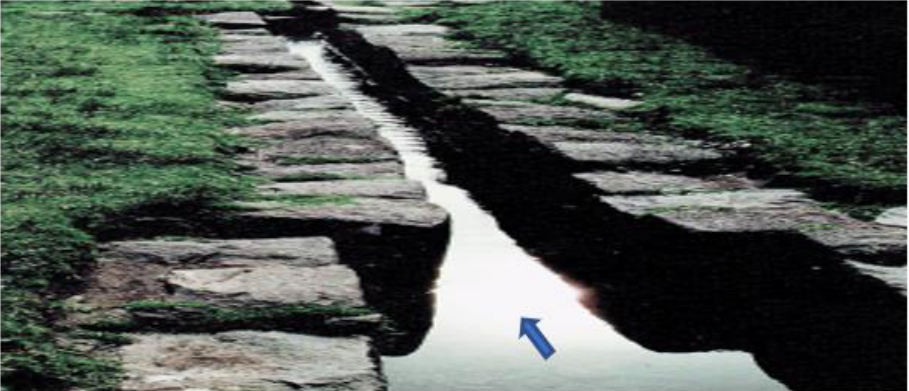
Figure 68. Alternate view of the contracted water supply channel, showing surface ripples normal to the flow direction. Photo by author.